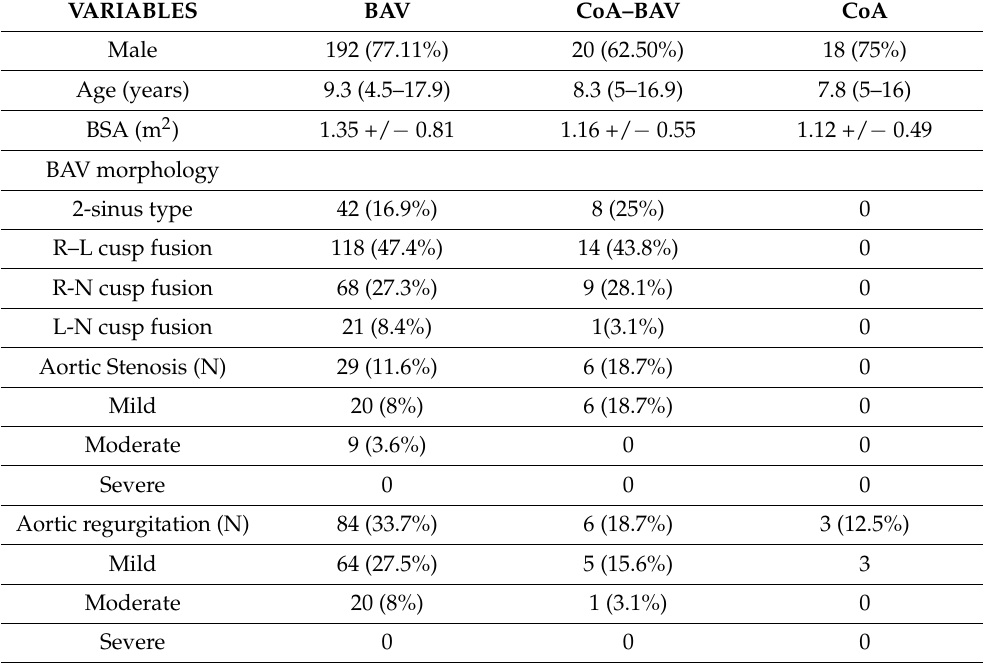
Table 1. Demographic and echocardiographic characteristics of the study population. BAV = bicuspid aortic valve; CoA = aortic coarctation; BSA = body surface area; R–L = right–left; R-N = right noncoronary; L-N = left noncoronary.